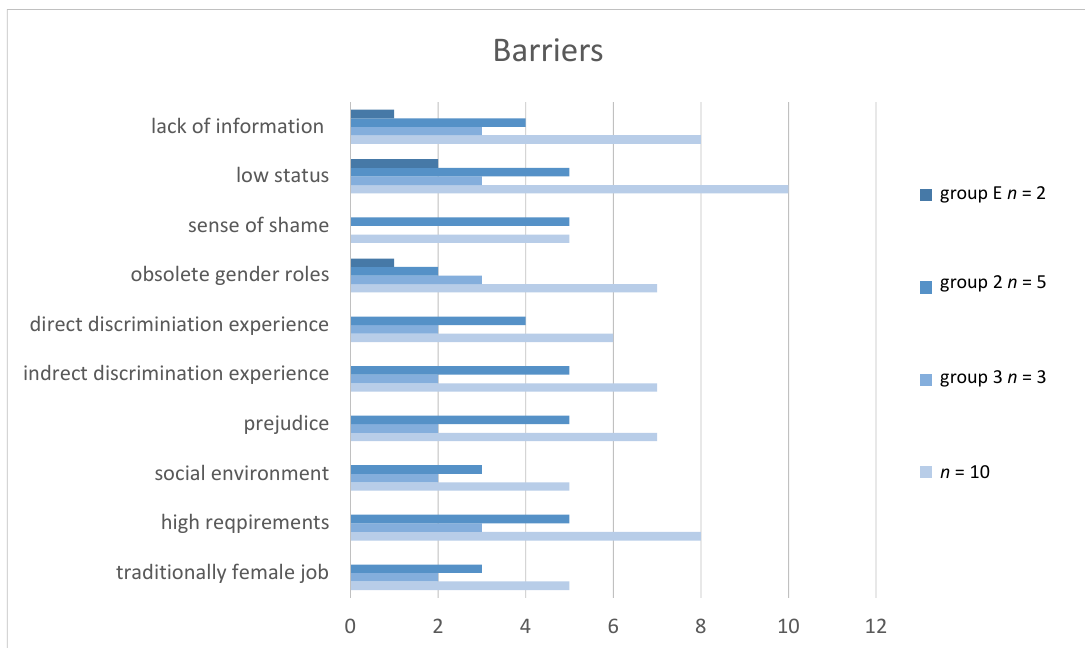
Figure 2. Results on the barriers during the access to nursing training school.